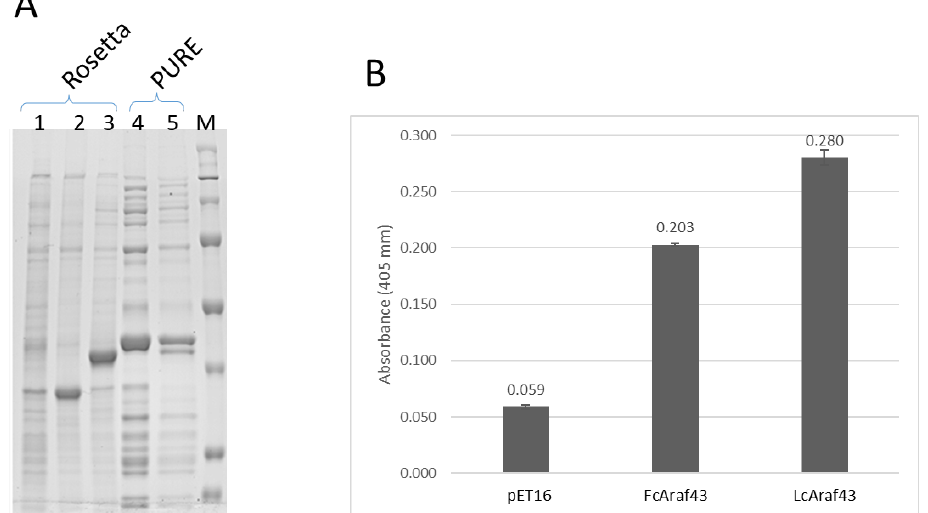
Figure 3. Expression and enzyme activity of FcAraf43. ( A ) Coomassie-stained SDS-PAGE gel of expression of the processed form of mFcAraf43 and the L. lactis - derived LcAraf43 control with known furanosidase activity expressed in the cell-free PURE system (lanes 4 and 5) and the full-length form of pET16b, FcAraf43 and LcAraf43 (lanes 1–3) in Rosetta (DE3). Lane 1: Negative control empty pET16 vector, Lane 2: Cell culture of FcAraf43 in BL21, Lane 3: Positive control cell culture of BL21-LcAraf43, Lane 4: FcAraf43 in PURE system, Lane 5: LcAraf43 expressed using PURE cell-free system and molecular weight standard. ( B ) Enzymatic activity of the proteins expressed in the PURE systems, including an empty vector control. The samples were incubated at 37 °C for 16 h and then measured at 405 nm to detect the amount of pNP. The bars represent the mean of three replicates, and the standard deviation is indicated by the error bars.